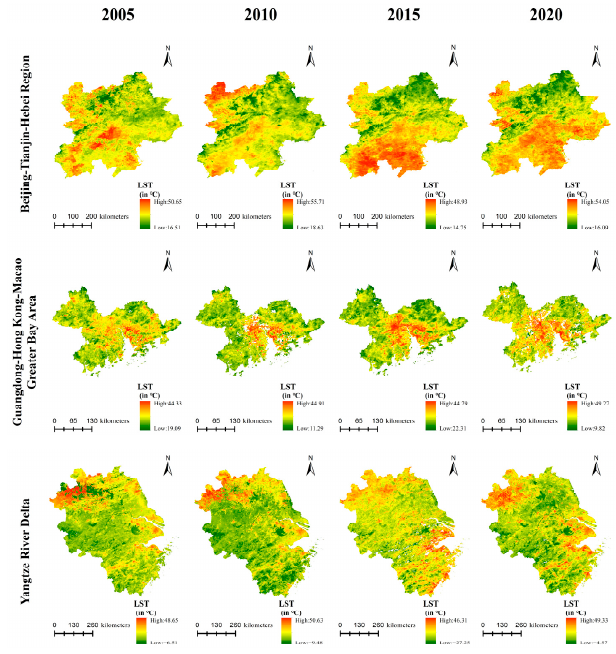
Figure 7. Spatiotemporal dynamics of LST pattern in study areas in 2005–2020.